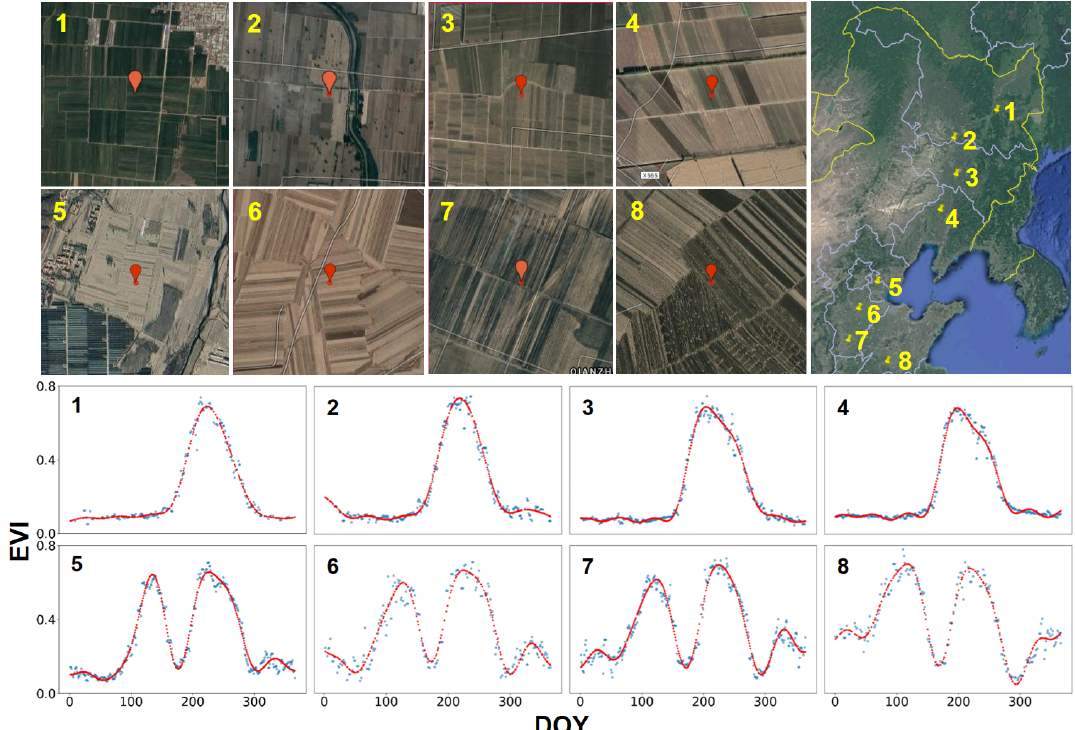
Figure 6. Performance of the harmonic model in fitting the time series data of EVI. Cases numbered 1–4, and 5–8 represent the spring and summer maize, respectively. The blue points are the original EVI series of red dots in the center of © Google Earth images, and the red points are the fitted